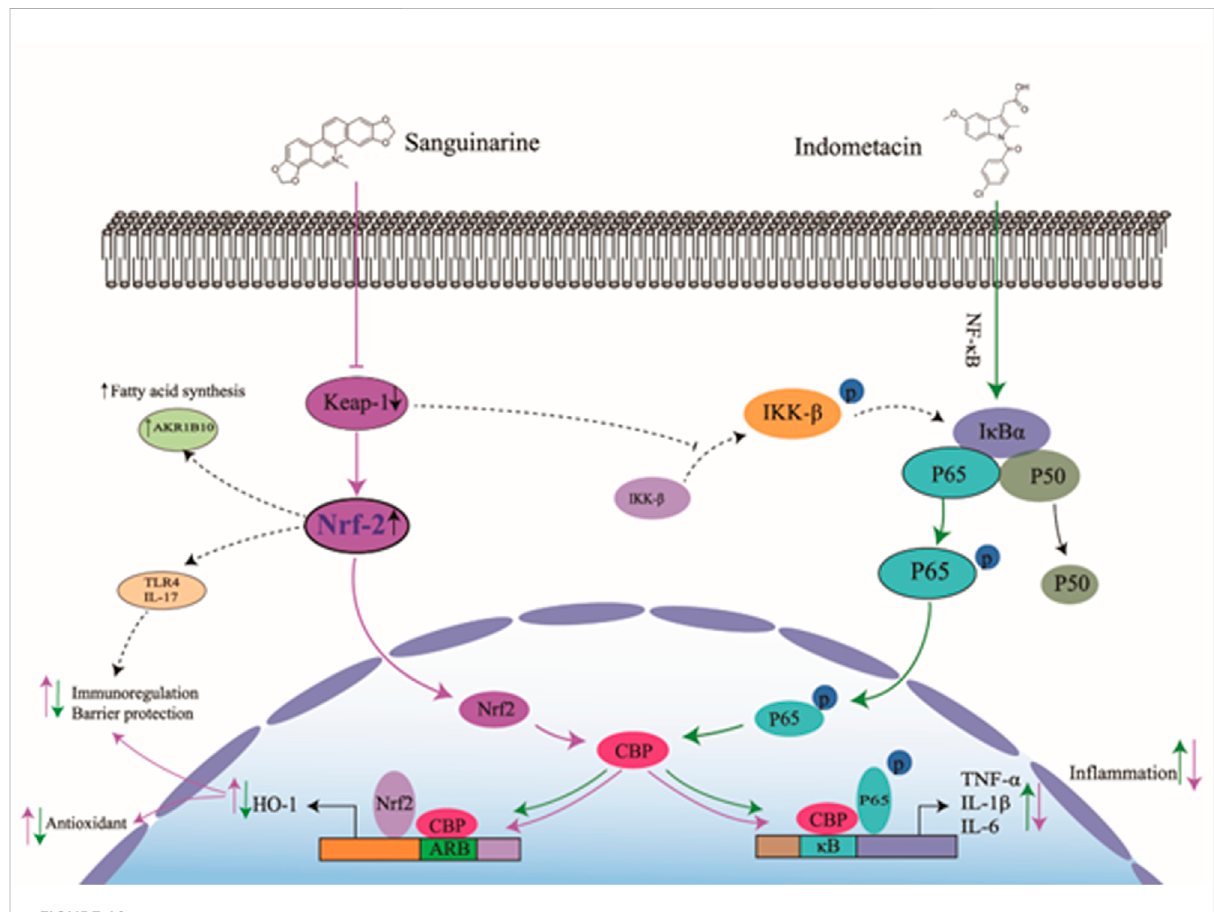
FIGURE 10 HypotheticmodelofSAprotectionfromNSAIDs-induedin fl ammatorydamageofsmallintestinethroughregulatingtheNrf2/NF-KBpathways. UnderthestimulationofNSAIDsandotherin fl ammatoryfactors,thein fl ammatorypathwayofNF-kBisactivatedinepithelialcellsandintestinaltract. P65 (an active subunit of NF-KB) is phosphorylated and depolymerized from the in fl ammatory complex composed of p65, p50 and I κ B- α . Then phosphorylated p65 (p-p65) enters the nucleus, binds with its target gene under the guidance of CBP, and induces the expression of in fl ammatory factors TNF- α , IL-6 and IL-1 β , which activate the in fl ammatory response of IEC-6 cells and intestinal mucosa, leading to in fl ammatory lesions. SA binds to Keap-1, inhibits Keap-1 and increases cellular expression of Nrf2, which competes with p-p65 to bind to CBP in the nucleus, and thenreduce theexpression ofTNF- α ,IL-6andIL-1 β .Ontheotherhand,theincreasedNrf2/CBPcomplexes promotetheexpressionofHO-1(target gene of Nrf2), so as to counteract the effects of in fl ammatory factors TNF- α , IL-6 and IL-1 β